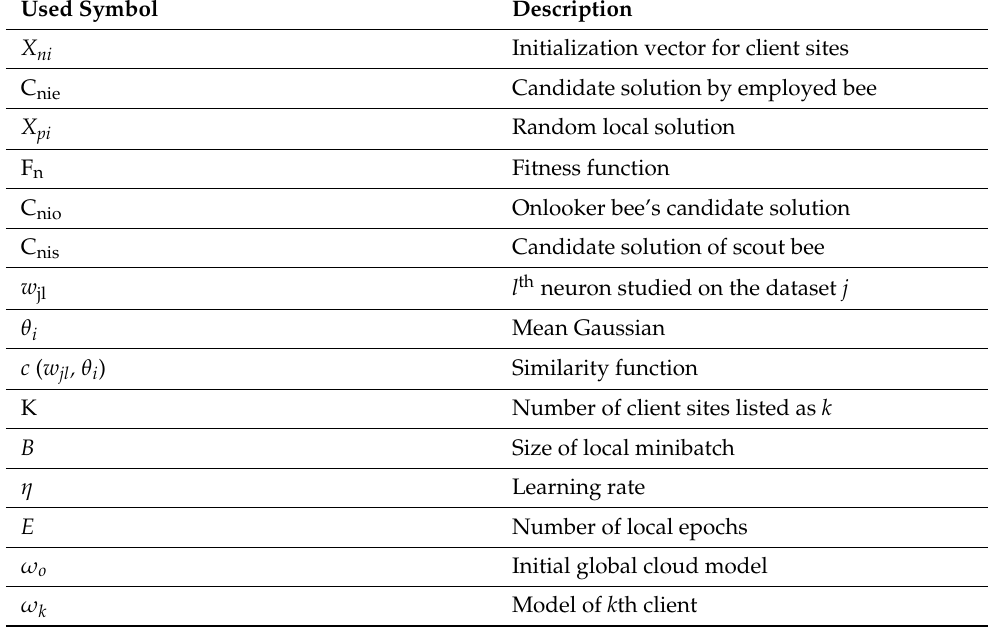
Table 1. Description of used symbols.